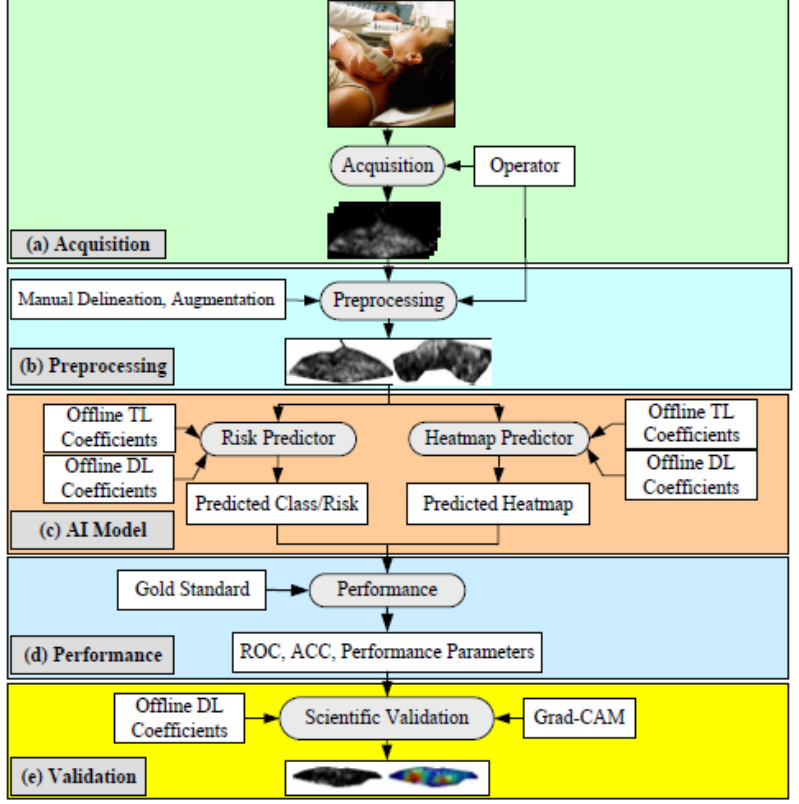
Figure 15. Deep learning model to predict vascular disease using AIbTC [44].